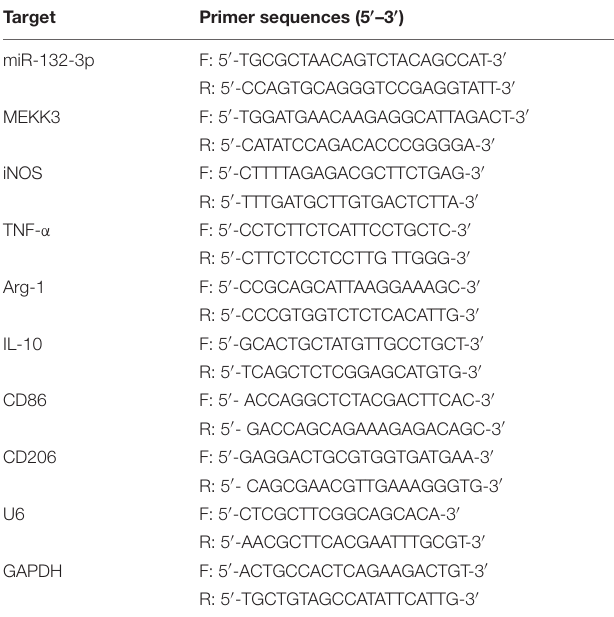
TABLE 1 | Primer sequences for